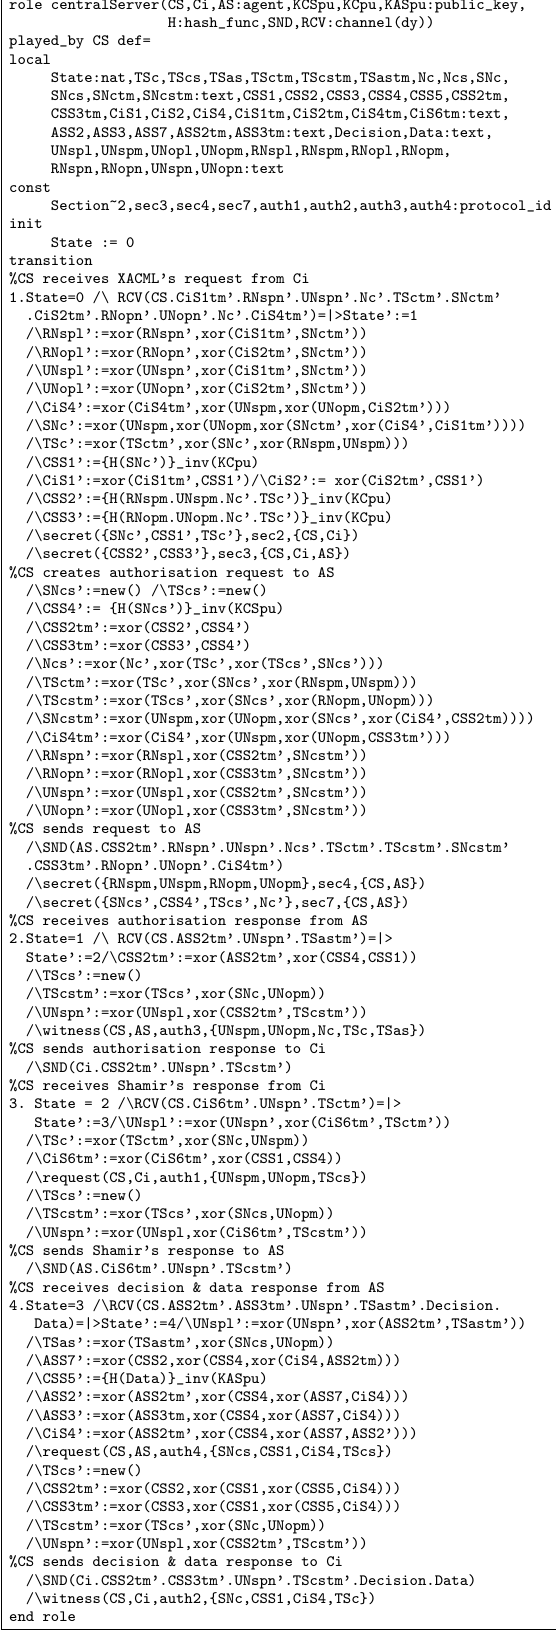
Figure A1. C i role of PAX in HLPSL. Figure A2. CS role of PAX in HLPSL. Figure A2. CS role of PAX in